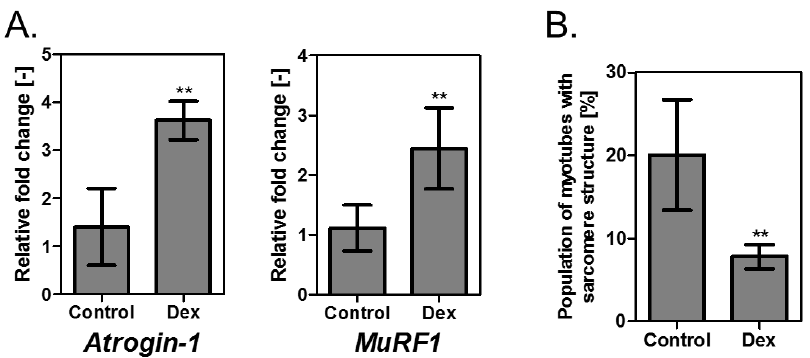
Figure 4. Characterization of atrophic muscle tissues induced by Dex. ( A ) Atrogin-1 and MuRF-1 gene expression levels in muscle tissues treated with 100 µ M Dex for 24–48 h are expressed relative to β -actin . mRNA was extracted from nine tissues each for the control and Dex. Results represent mean ± SD ( n = 5) ** p < 0.01 versus control; ( B ) Percentage of myotubes with the sarcomere structure in muscle tissues treated with 100 µ M Dex for 24 h. Results represent mean ± SD ( n = 6). Totally 190 myotubes were analyzed for control, and 136 myotubes were analyzed for Dex. ** p < 0.01 versus control.